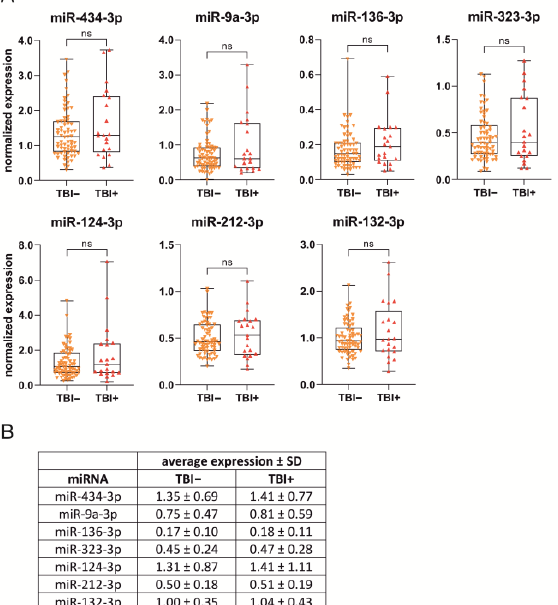
Figure 5. Normalized plasma miRNA levels on D2 and epilepsy outcome. ( A ) Box and whisker plots (whiskers: minimum and maximum; box: interquartile range; line: median) showing comparable plasma miRNA levels in the injured rats with (TBI+) and without (TBI − ) epilepsy (Mann–Whitney U test, p > 0.05 for all miRNAs). ( B ) A table summarizing normalized miRNA expression levels (mean ± SD) in the TBI − and TBI+ groups. Abbreviations: ns, not significant; SD, standard deviation; TBI, traumatic brain